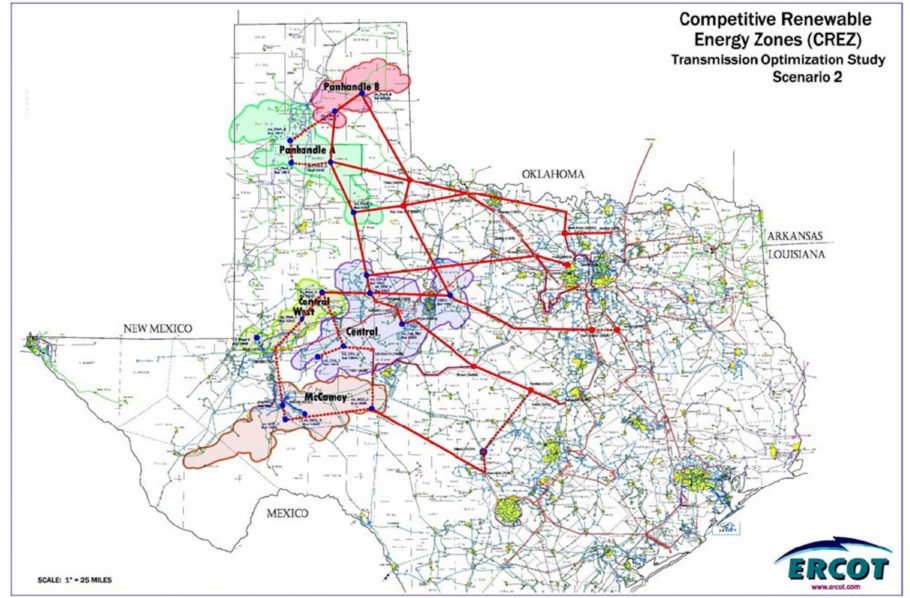
Figure A1. CREZ reinforcement for scenario 2